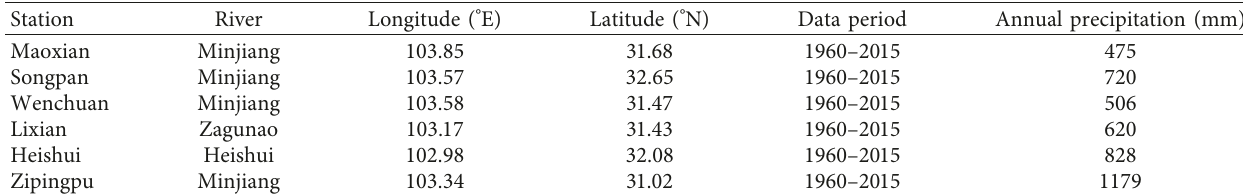
Table 1: Detailed information of gauging